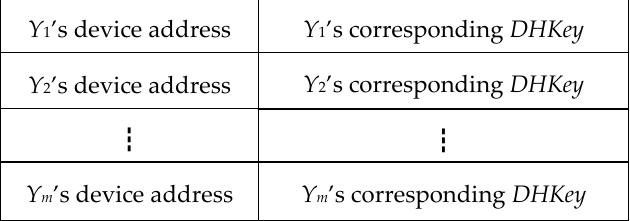
Figure 8. The device X ’s pairing information table.